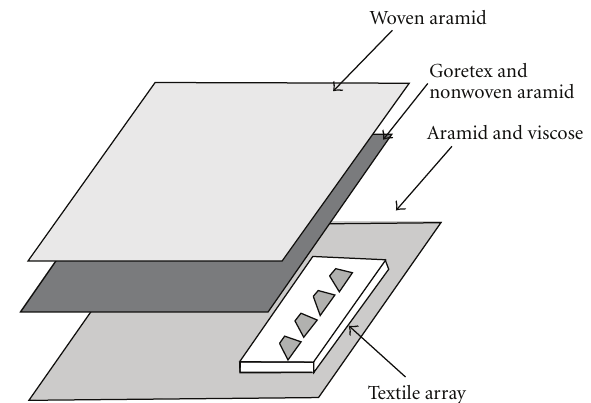
Figure 14: Antenna between textile layers composing the firefighter suit.